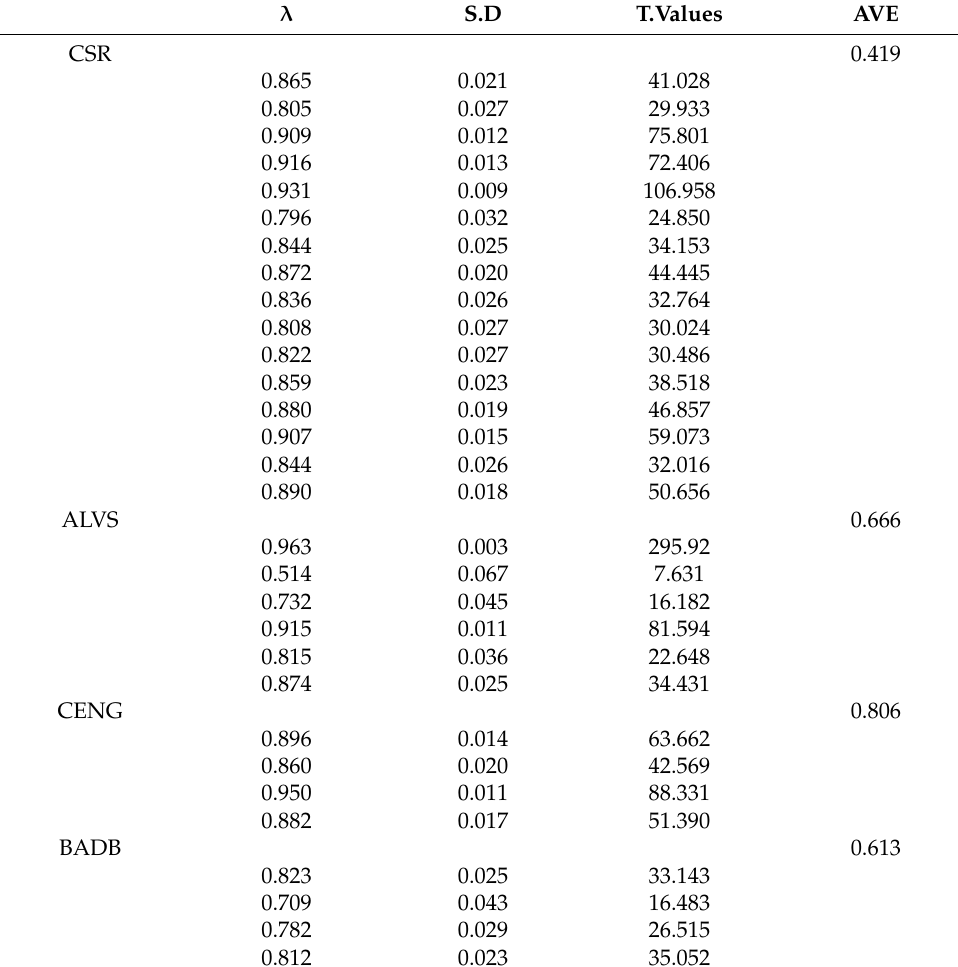
Table 3. Outer loadings and